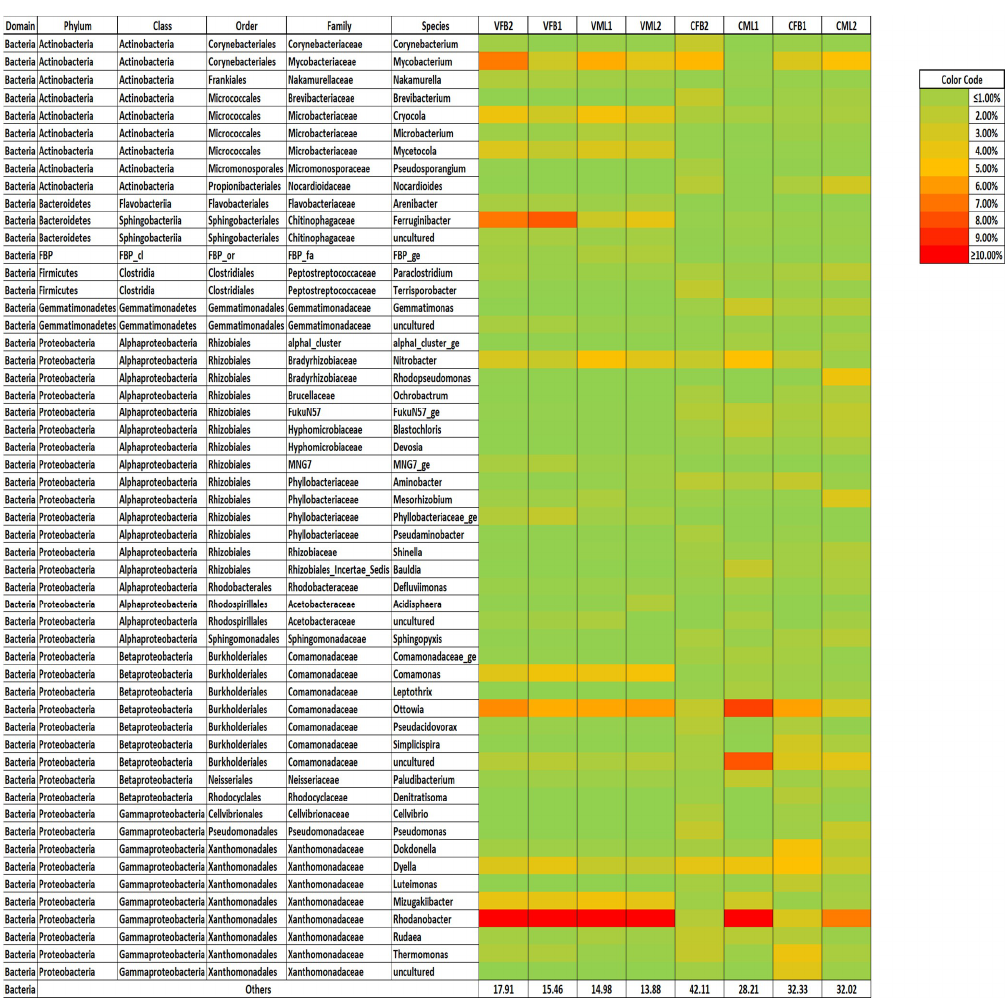
Figure 3. Heat map of bacterial community structure of genera with at least >1% relative abundance in at least one sample. at least one